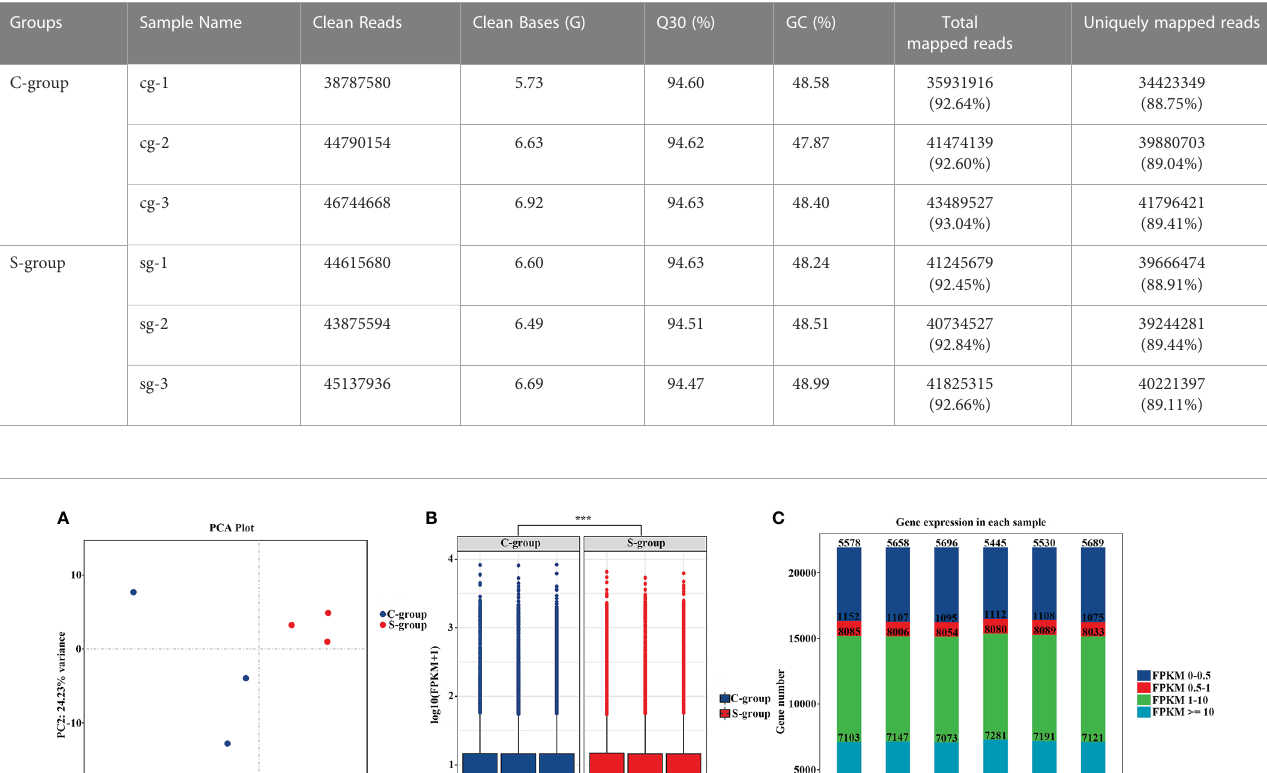
TABLE 2 Summary of gill RNA-seq data of large yellow croaker under low-salinity stress.